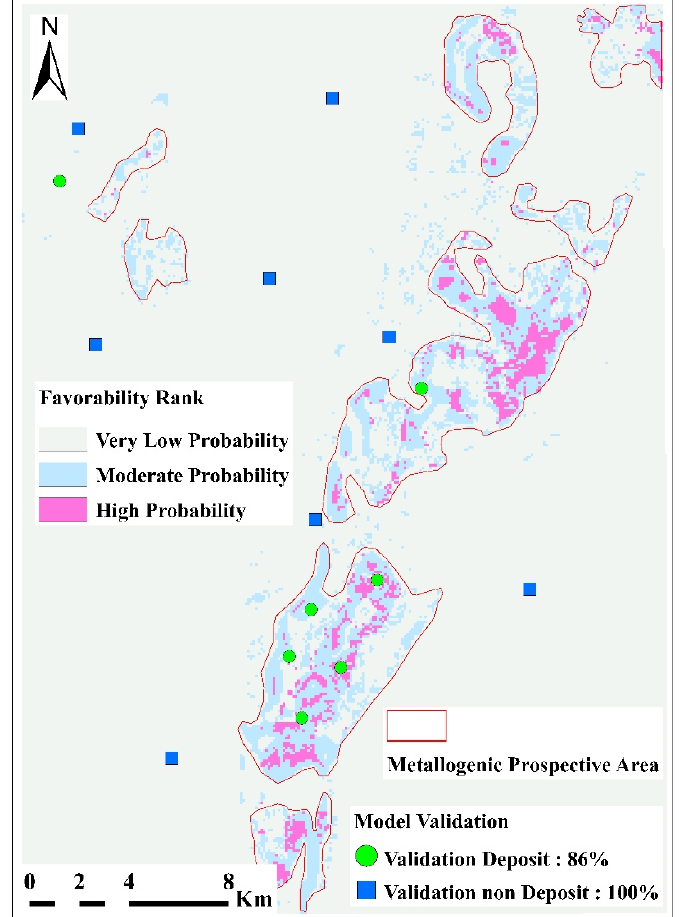
Figure 12. Prospective map of mineralization.